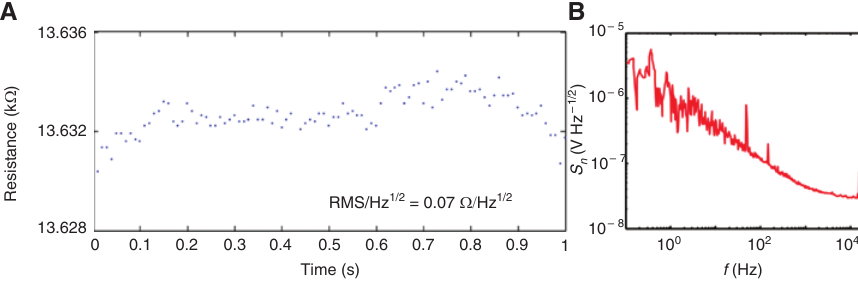
Figure 10: Noise characteristics of the hybrid detectors: (A) Fluctuations of the channel resistance in the graphene transistors with PbS QDs [7]; (B) noise vs. the modulation frequency in the integrating diode-transistor detector [68].